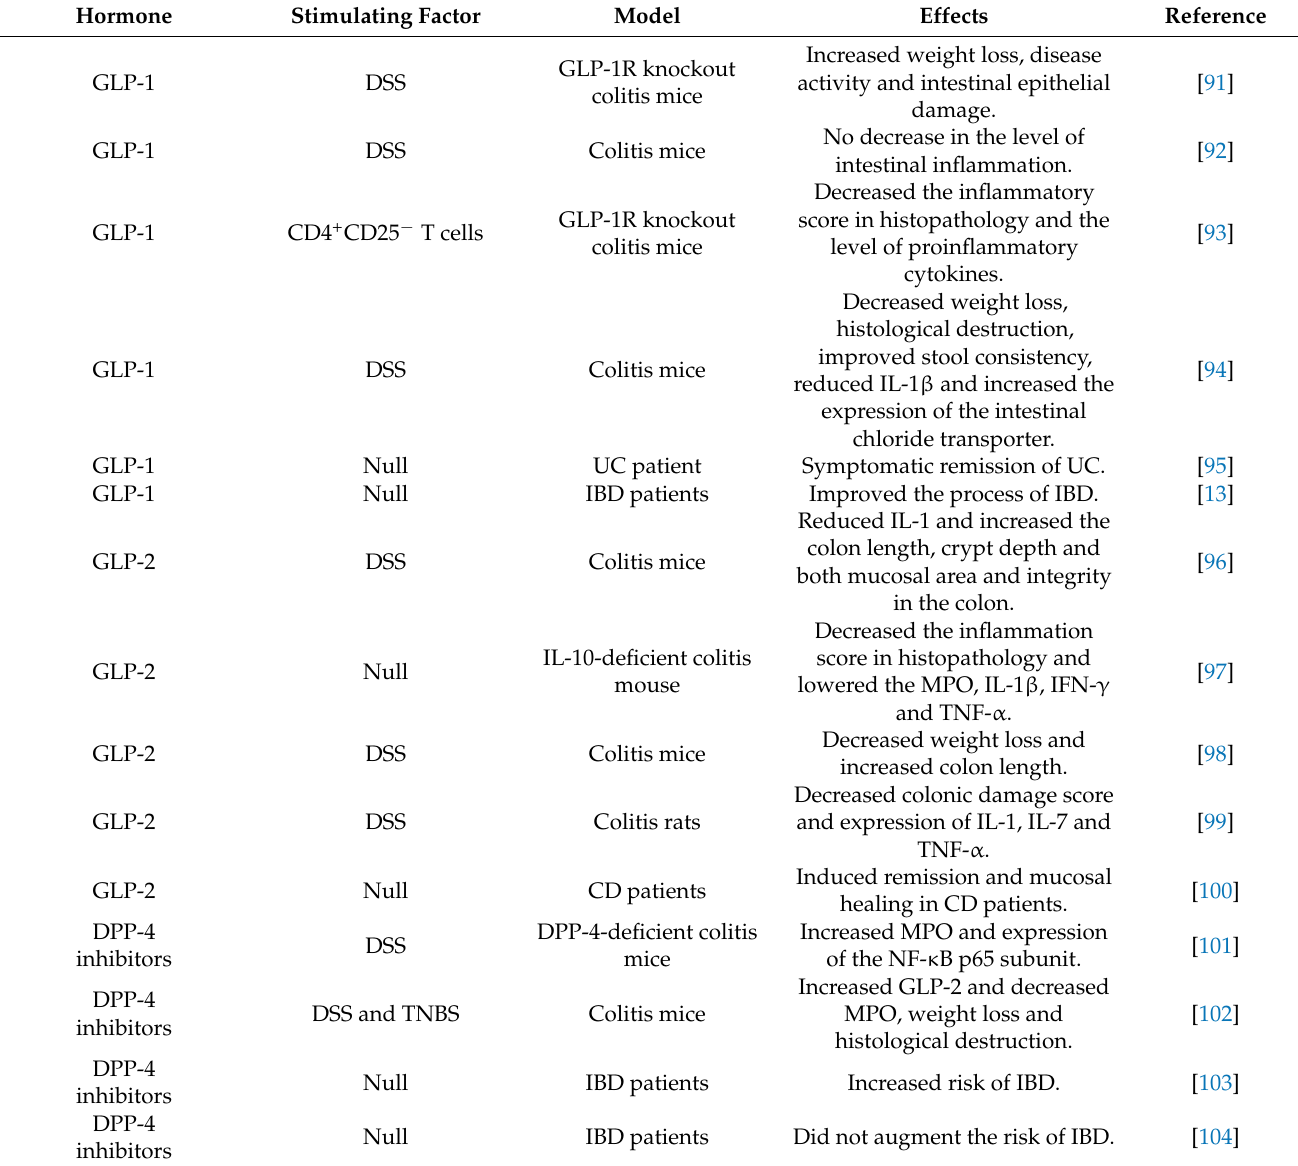
Table 2. Modulation of IBD by GLPs and DPP-4